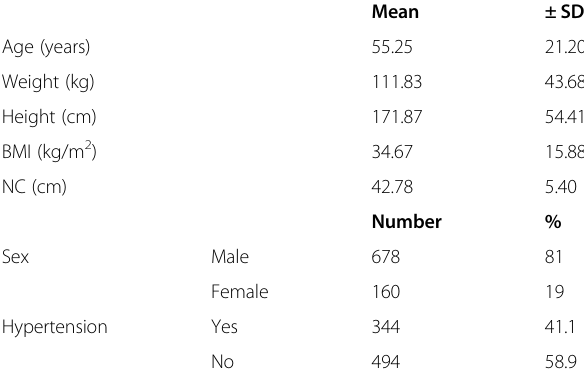
Table 1 Demographics and clinical characteristics of patients diagnosed with OSA